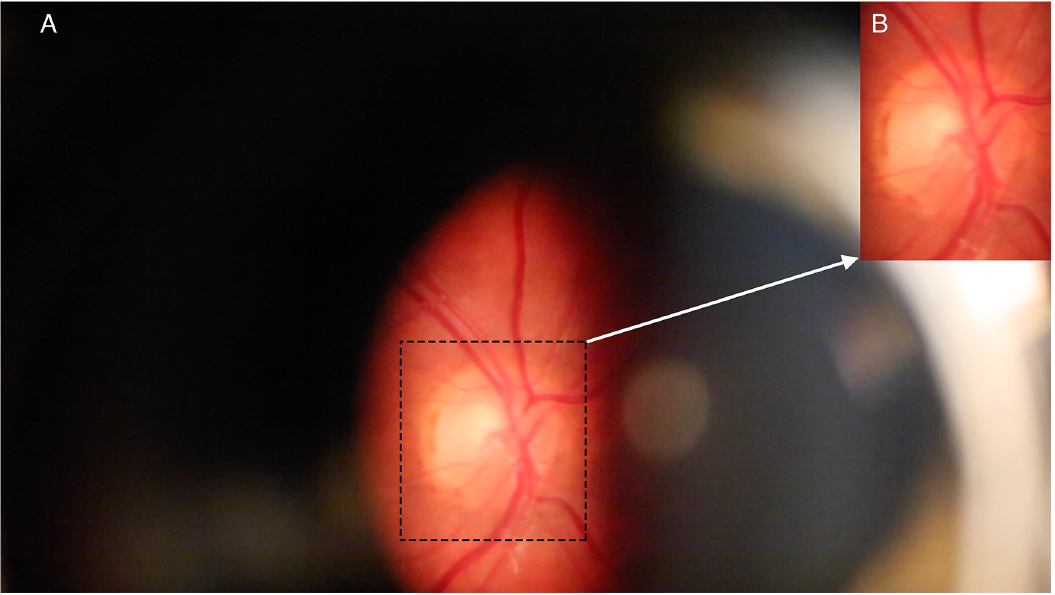
Fig 1. Example of the image zone of analysis. A) Full frame image as viewed through the Meditron ophthalmodynamometer. B) Inset showing the region of interest after cropping the image.